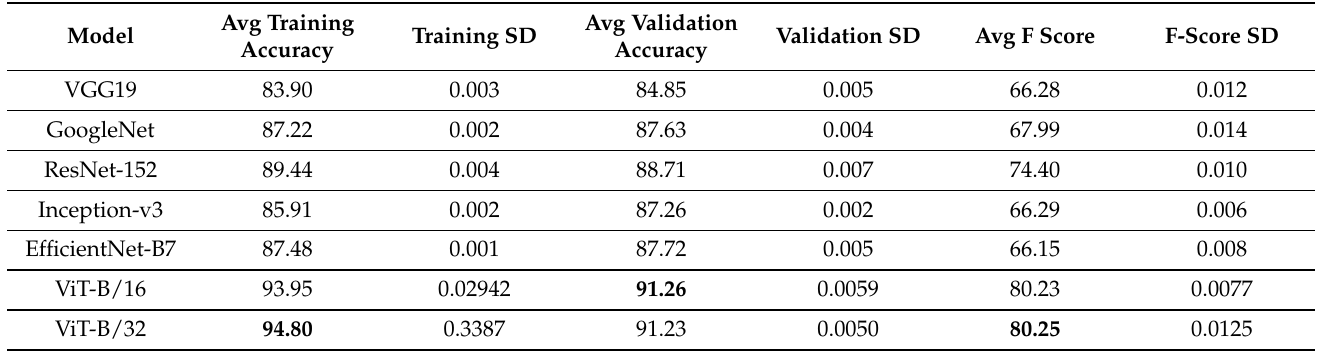
Table 5. Multi-label classification results for road weather detection using focal loss function to force models to handle difficult-to-classify weather images (best performance in